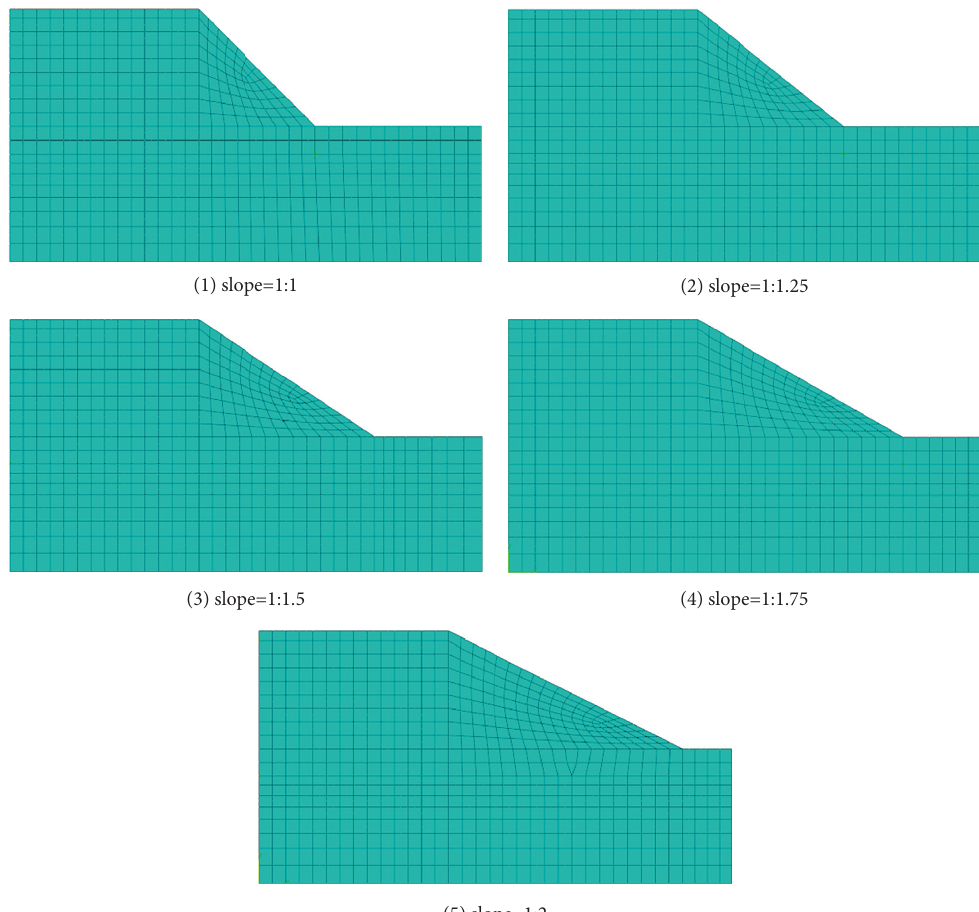
Figure 3: FEM meshes for the five types of slopes. (a) Slope � 1:1. (b) Slope � 1:1.25. (c) Slope � 1:1.5. (d) Slope � 1:1.75. (e) Slope �